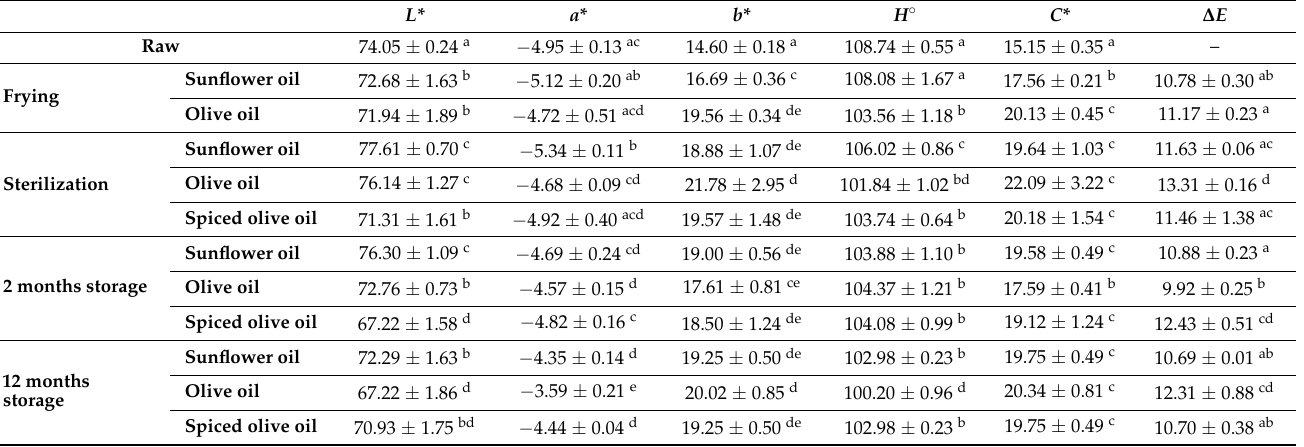
Table 2. Colour parameters of raw and canned European eels packed in sunflower oil, olive oil or spiced olive oil at the different steps of the canning process, and after 2 and 12 months of storage. Values are means ± standard deviations of three